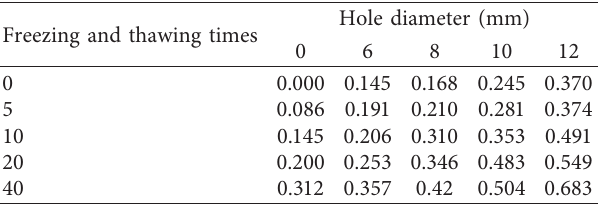
Table 3: Damage degree of yellow sandstone with pores under freezing and thawing.